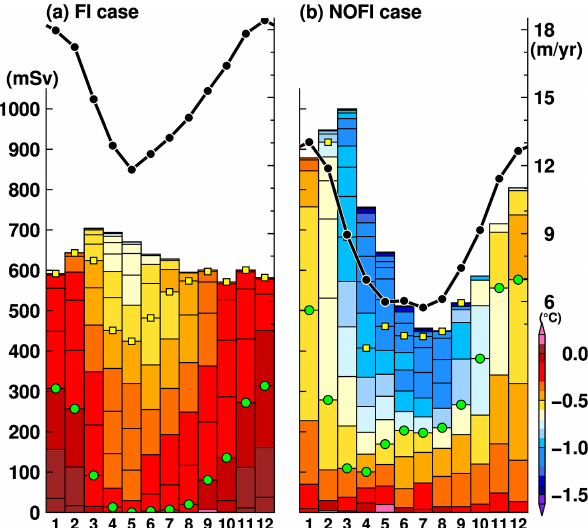
Figure 14. Seasonal variation in water mass transport flowing into the SGT cavity (mSv, left axis for boxes) with the potential tem- perature in potential density anomaly bins of 0.02kgm − 3 (color) and the mean basal melt rate (myr − 1 , right axis for black lines) in the (a) FI and (b) NOFI cases. Green dots and yellow squares rep- resent boundaries of 27.5 and 27.4kgm − 3 of the potential density anomaly, respectively. The variables were averaged over the period 2008–2018.